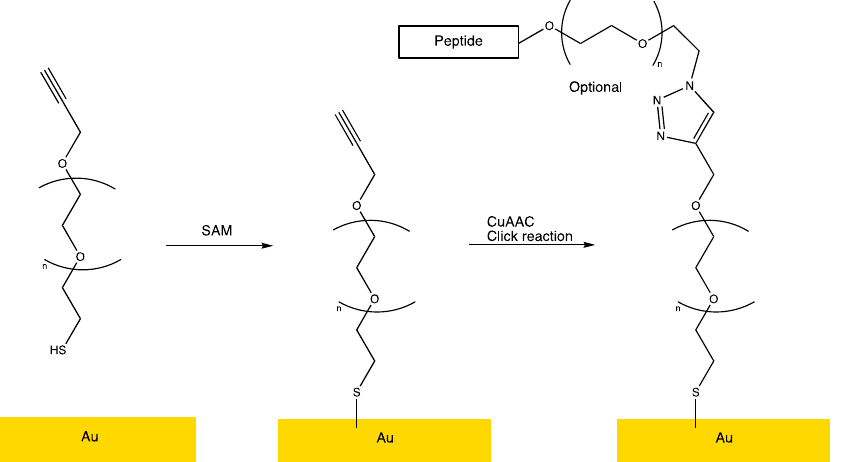
Figure 2. The preparation of the peptide-functionalized Au(–SAM) surface. A hydrophilic Au–SAM surface was made by reacting an Au(111) substrate with α -thio-PEG600- ω -alkyne ( left → middle panel). The peptide-functionalized surface was created by a CuAAC reaction between the acetylene terminated Au–SAM surface and an azide-functionalized peptide ( middle → right